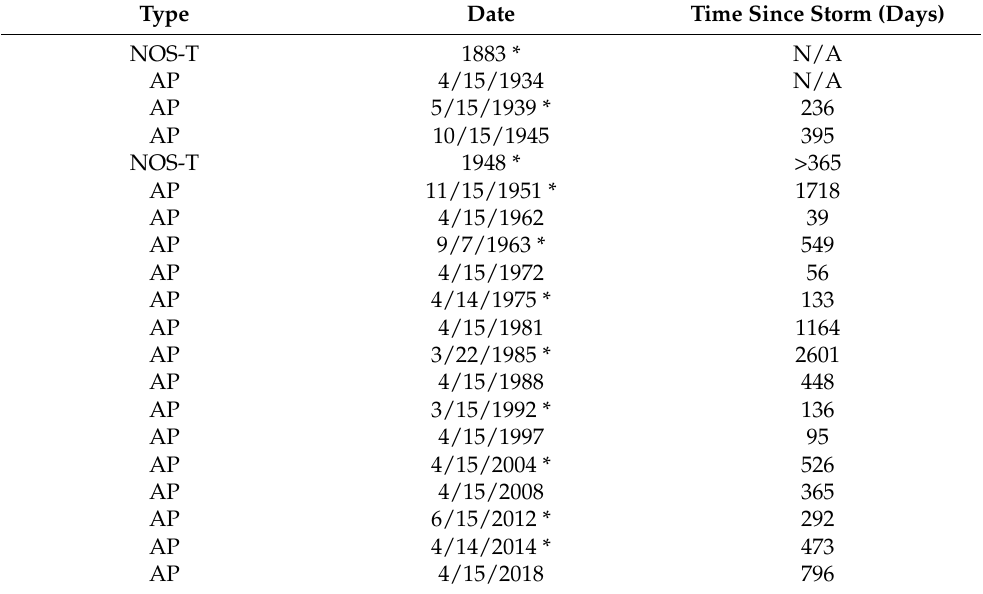
Figure 5. ( A ). Oblique aerial photograph of the Napatree Barrier and Sandy Point Barrier taken in 1936. Note the beach cottages and the presence of dune vegetation along the barrier. ( B ). Oblique aerial photograph of the Napatree Barrier taken on 24 September 1938, 3 days after the 1938 hurricane made landfall. North is to the left of both images, ( A , B ). Note the inlet at the east (far) end of the barrier and numerous surge channels across the barrier. ( C ). An oblique aerial photograph taken after Hurricane Carol (1954) of the eastern end of the NPCA (note the two groins installed between 1948 and 1951) ( D ). Car buried in a washover fan on the east end of the Napatree Barrier during Hurricane Carol (1954). This photograph is just out of frame to the east of Figure 5C. See Figure 1 for the location of the photograph [62]. View is towards the east. Table 2. NOS T-Sheets (NOS-T), aerial photographs (AP) and digital orthophotos (DO) used in this study. Dates with an asterisk denote that a dataset was used to digitize a shoreline position. Time since storm indicates the number of days between the photograph/survey and last time the threshold water level (0.7 m MHHW) was exceeded at the Newport tide